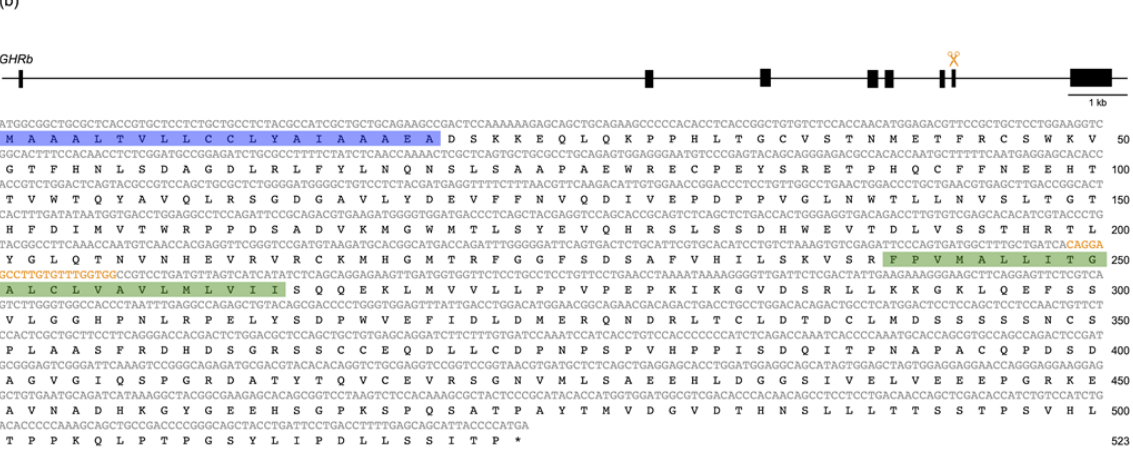
Figure 1. Genomic structure of the somatolactin alpha receptor ( SLR: GHRa ) ( a ) and growth hormone receptor ( GHR: GHRb ) ( b ) genes (GenBank accession numbers: DQ002886 and DQ010539, respectively). The black boxes represent translated regions (the 5 (cid:48) /3 (cid:48) UTRs are not shown). The orange scissors indicate the approximate positions of the target sequences in CRISPR/Cas9. The cDNA and amino- acid sequences are shown in gray and black, respectively. The target sequences are shown in orange. The signal peptides predicted by SignalIP 5.0 and the transmembrane regions predicted by TMHMM 2.0 are highlighted in blue and green,